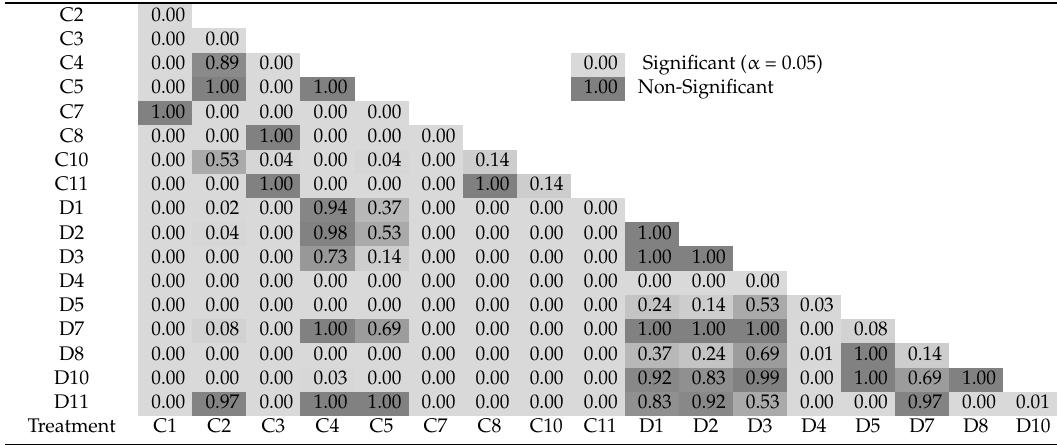
Figure 3. ( a ) Descriptive statistics of measured grass above-ground biomass; ( b ) significant difference amongst different levels of mowing and burning grassland management treatments based on analysis of variance test. Bars represent mean biomass of each management treatment level while whiskers represent confidence intervals of means at 95%. Table 3. Significant differences between different pairs of grass above-ground biomass grown under different levels of mowing and burning treatments, based on the Tukey’s HSD test.